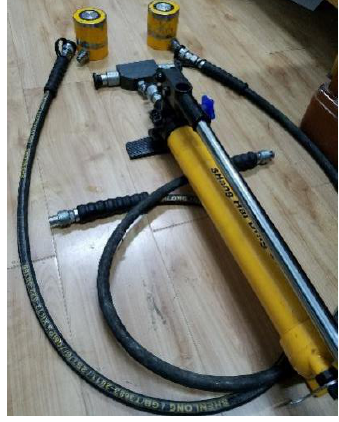
Figure 10. Manual oil pump.